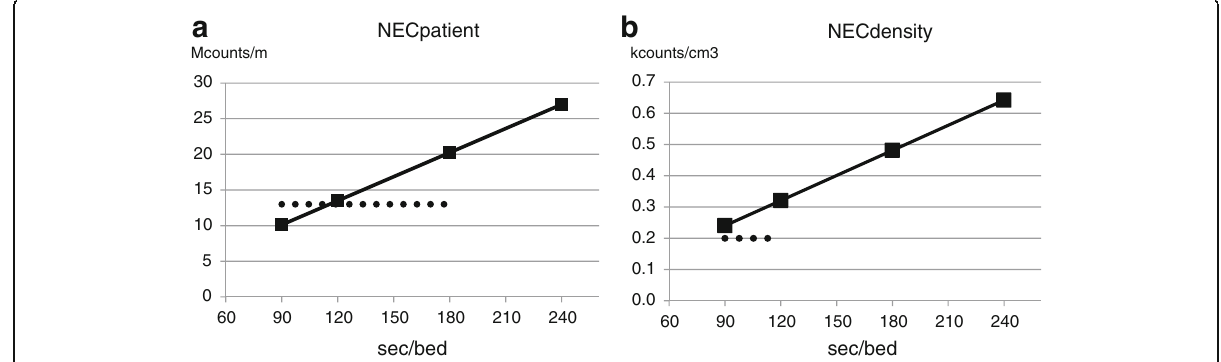
Fig. 11 NECpatient ( a ) and NECdensity ( b ) values of the images reconstructed for 90, 120, 180, and 240 s/bed position. The dotted lines indicate the recommended values (NECpatient > 13 Mcounts/m, NECdensity > 0.2 kcounts/cm 3